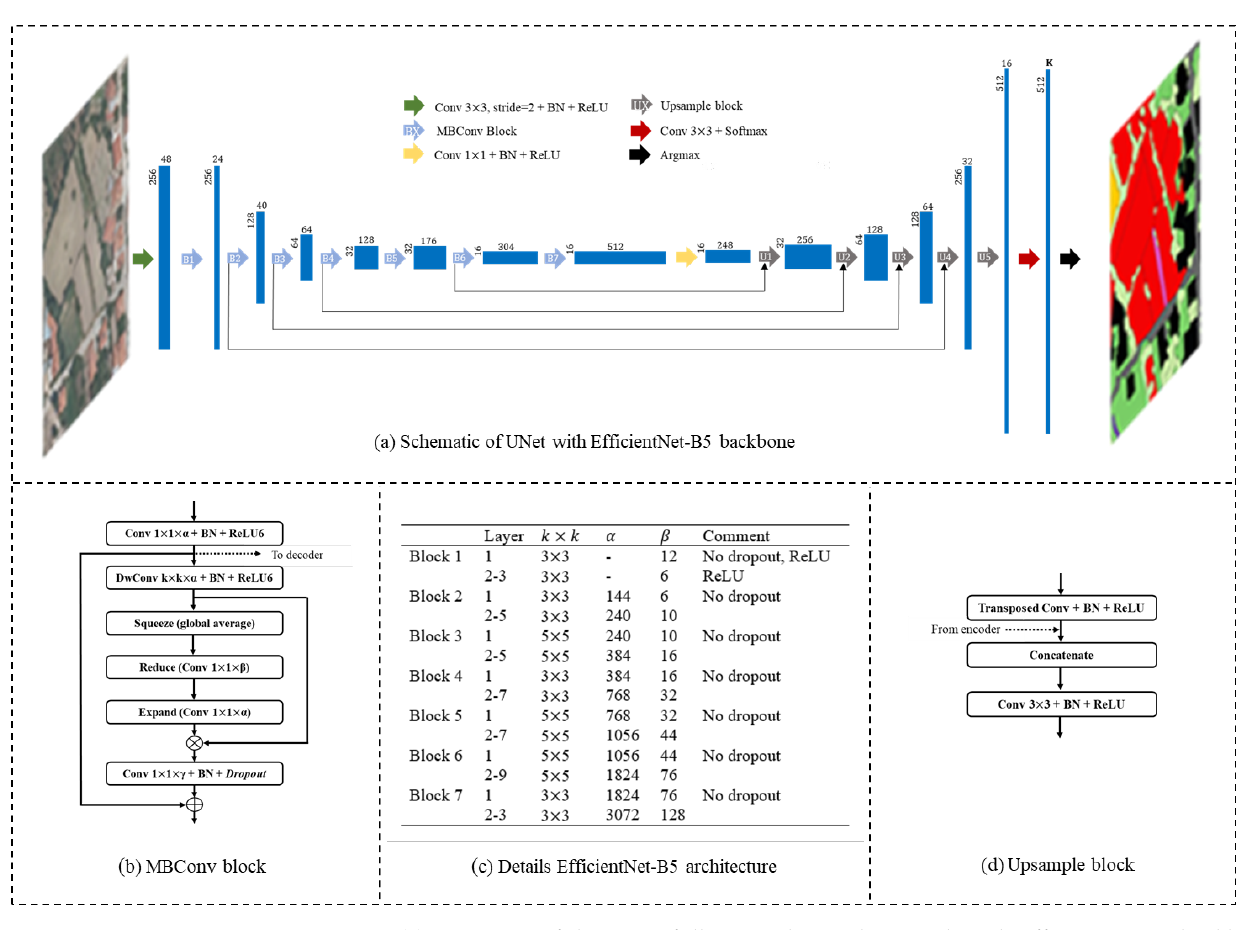
Figure 5. ( a ) Overview of the UNet fully convolutional network with EfficientNet-B5 backbone. The horizontal values indicate the number of filters. The vertical values indicate the image height and width (H = W). K equals the number of LULC classes. Detailed schematics are given for the mobile inverted bottleneck with squeeze-and-excitation building block (MBConv) and the upsample building block in pane ( b , d ), respectively. The filter kernel sizes k × k, and number of filters α and β for the multiple MBConv blocks are specified in pane ( c ). BN = batch normalization, ReLU = rectified linear unit, DwConv = depthwise 2D separable convolution (always with stride =